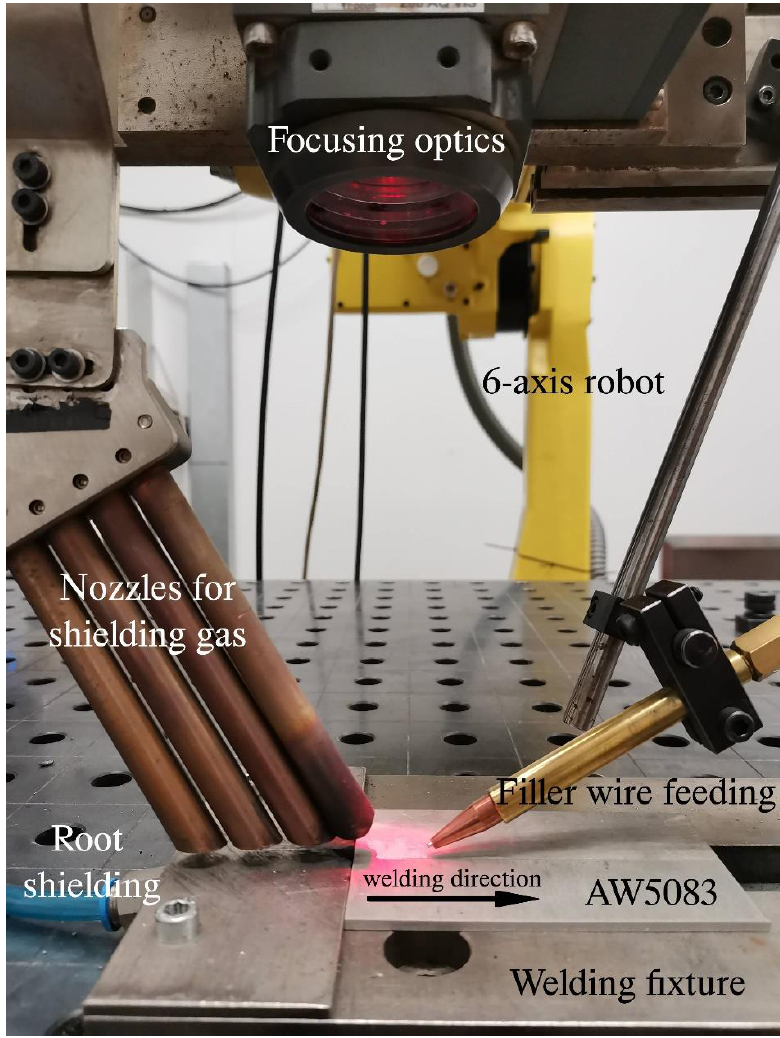
Figure 1. Photographic image showing the scheme of the experimental procedure.